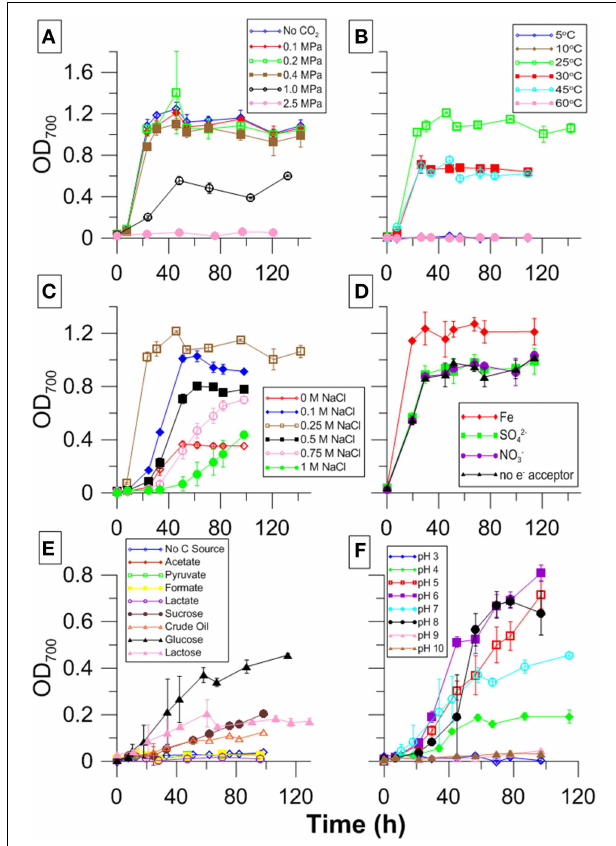
FIGURE 6 | CG-1 physiological data showing growth with varying (A) P CO 2 , (B) temperature, (C) salinity, (D) electron acceptor, (E) carbon source, and (F)